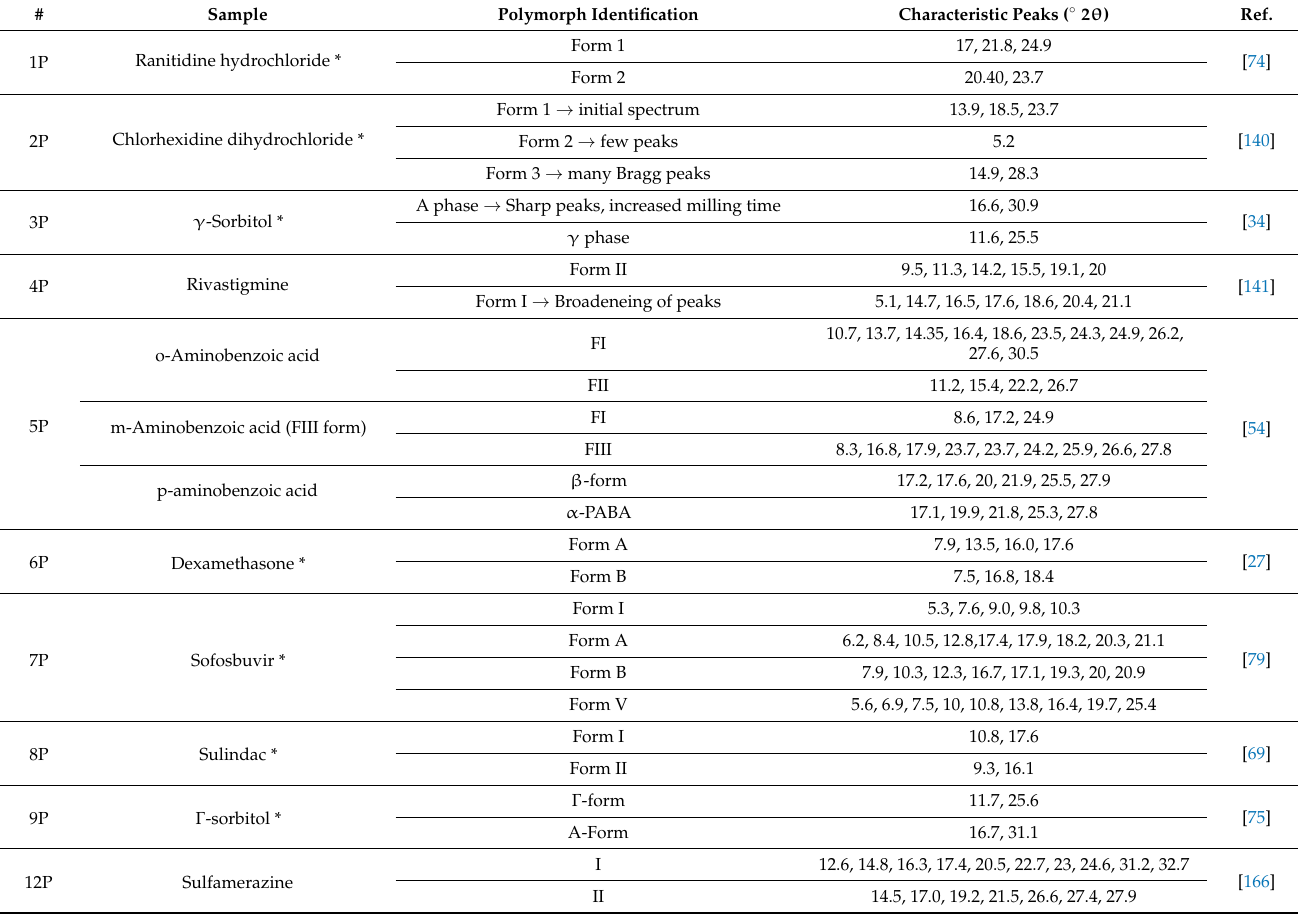
Table 13. Overview of identification of diffraction peaks for